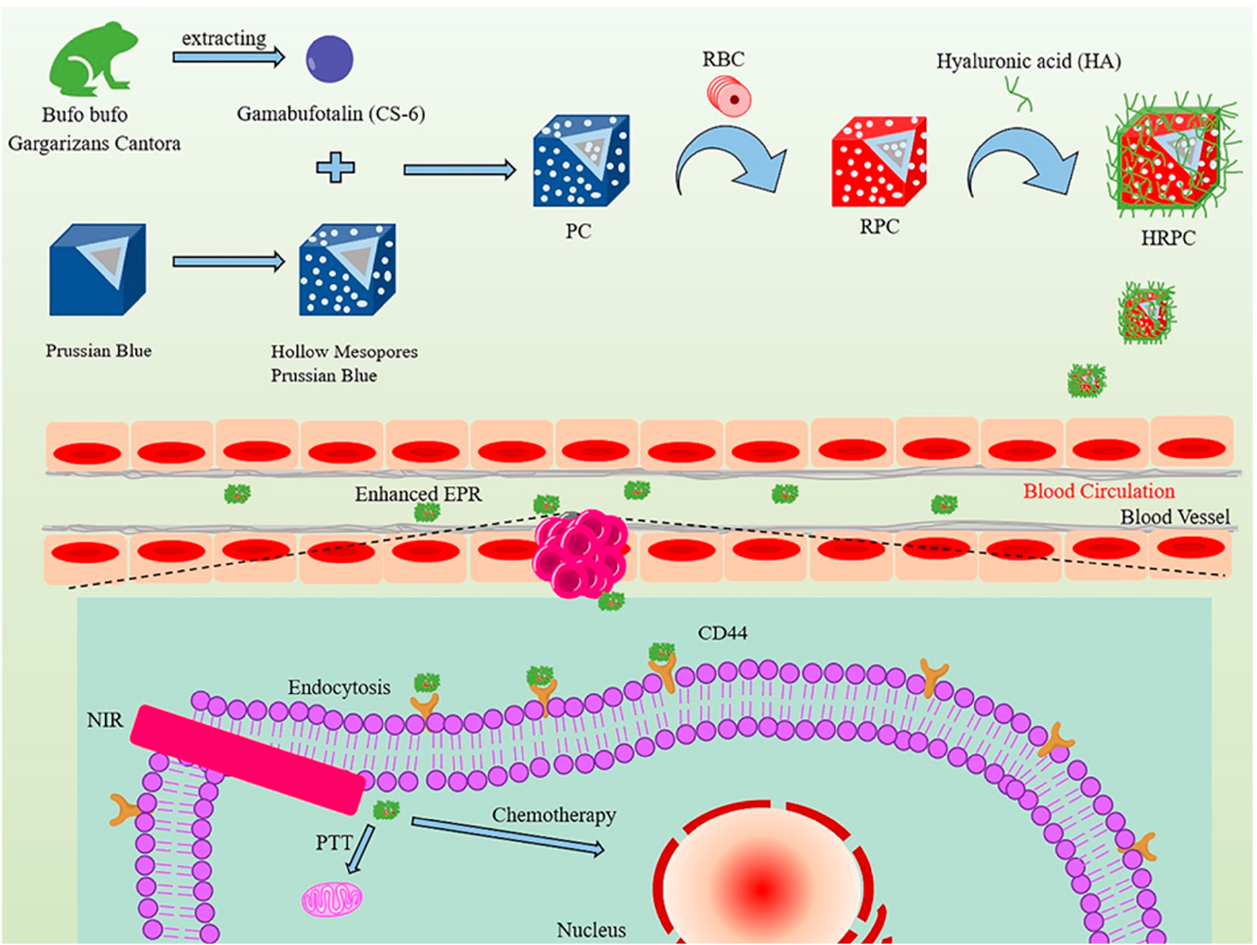
Figure 9. The illustration of a targeted nanodrug system loaded with CS-6 for breast cancer therapy, as well as its synthesis. Adapted from [116].